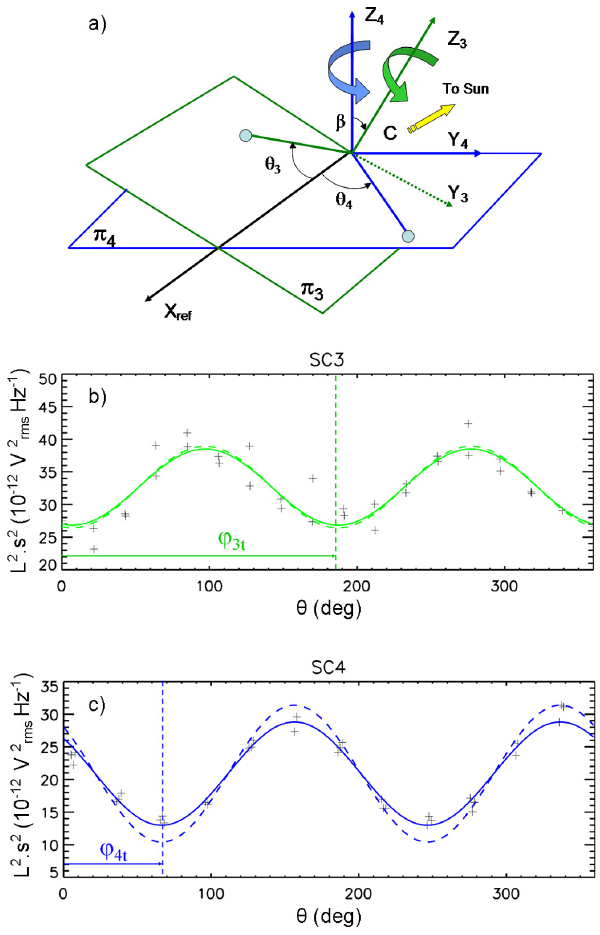
Fig. 1. (a) Configuration of spin axes ( Z 3 and Z 4 , making an angle β ) and spin planes ( π 3 and π 4 ) of the C3–C4 pair. Curved arrows indicate the sense of rotation (with time) of each receiving antenna, sketched as half a dipole. The [ S C4 ] and [ S C3 ] coordinate systems are defined by the axes Z 4 (respectively Z 3 ), X ref (common axis along intersection of spin planes) and Y 4 (respectively Y 3 ). The an- tenna attitude angles, θ 4 on C4 and θ 3 on C3, are expressed from the common origin X ref to the unit vector associated to the antenna. (b) and (c) Electric field spectral power densities in the 15–25kHz band and integrated over the antenna length L , sampled over a one minute time interval (18 May 2008, 12:20 to 12:21UTC) at a 1.7s recurrence, are plotted (grey crosses) versus attitudes 2 at sampling times, respectively for C3 (top) and C4 (bottom). Solid lines display a fit to the measured quantities according to a modelled spin vari- ation. Dashed lines display the derived instantaneous values of the modelled electric field (see text). Quantities φ 3t and φ 4t are best estimates of attitudes at minimal